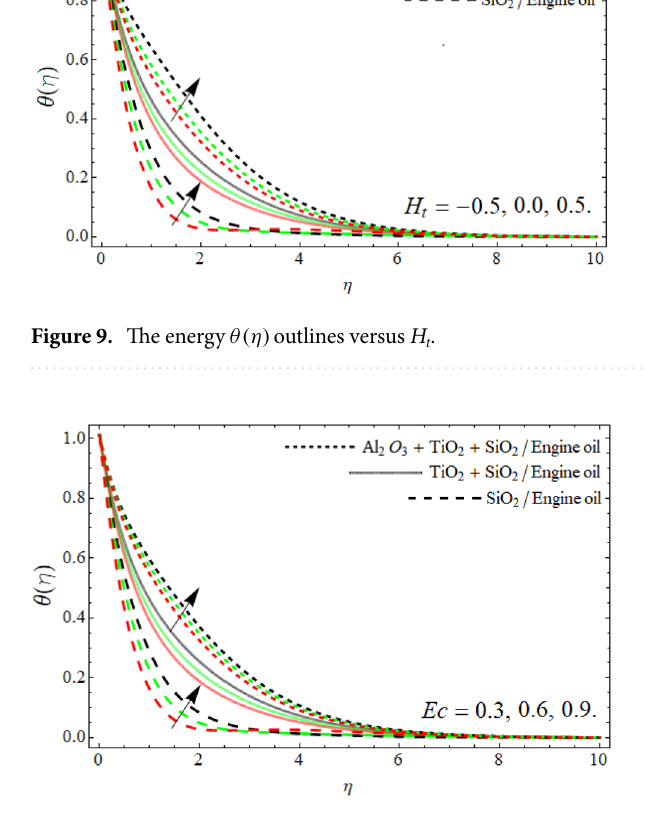
Figure 10. The energy θ(η) outlines versus Eckert number Ec .